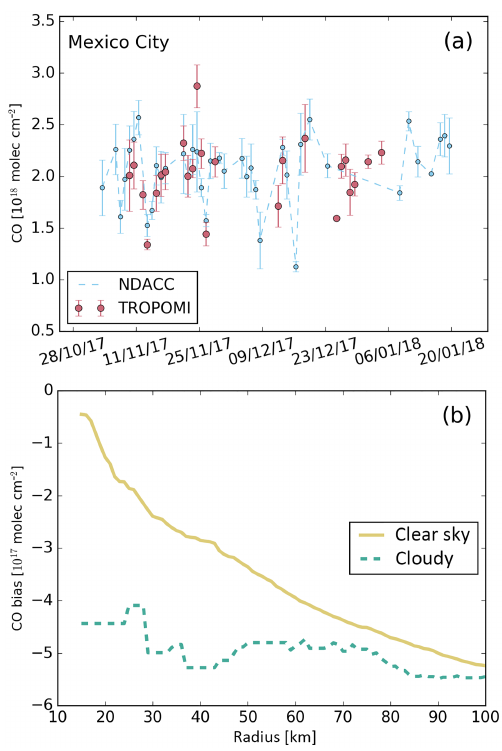
Figure 7. (a) Mexico City daily mean CO columns from TROPOMI (pink) and FTS (blue) with standard deviation of the individual retrievals (errors). TROPOMI observations are filtered for clear- sky within 15km around the ground site. The TROPOMI columns are altitude corrected to the station elevation. (b) Bias of the CO columns (TROPOMI – FTS) as function of the co-location ra- dius around Mexico City. Here, TROPOMI retrievals under clear- sky conditions (yellow) and optically thick clouds above 4000m (green) are considered. For the smallest radius (15km) we found 20 cloudy and 160 clear-sky collocations. However, for the widest ra- dius (100km) 92 cloudy and 4425 clear-sky collocations are found. No de-striping was applied on the TROPOMI